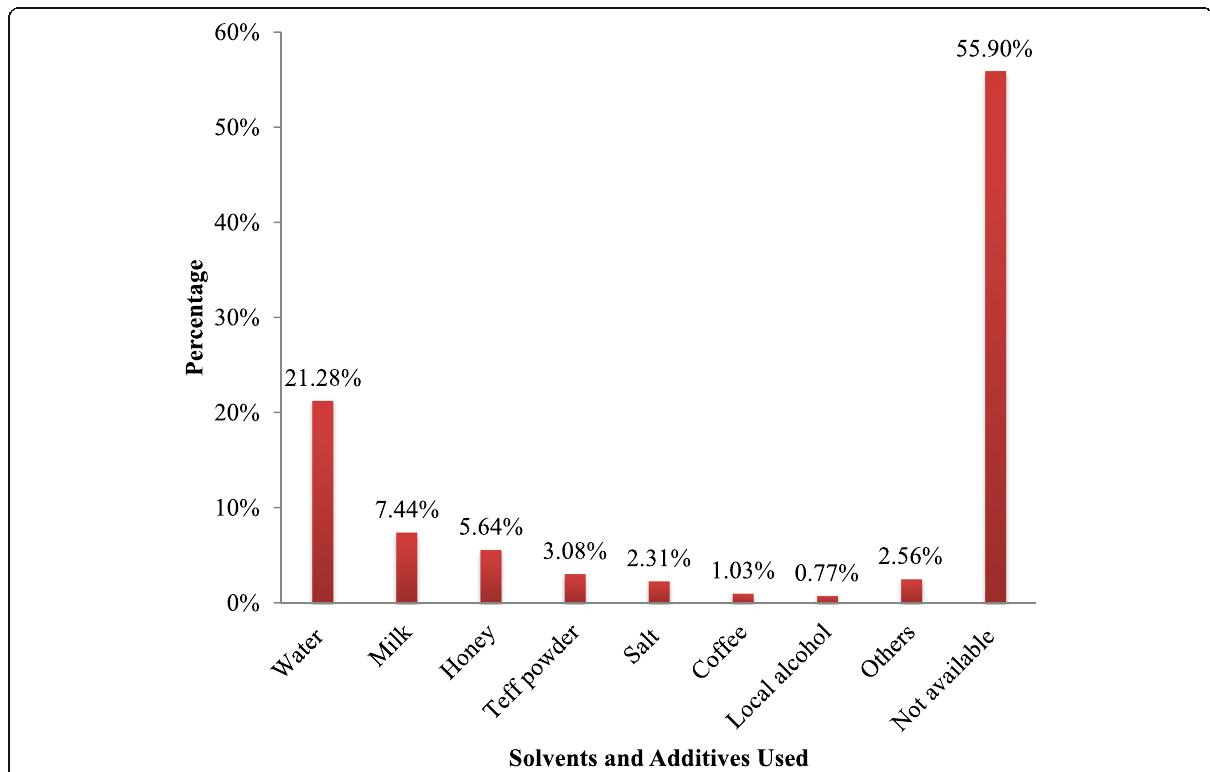
Fig. 4 Solvents and additives used for the preparation of plants for hepatic disorders in